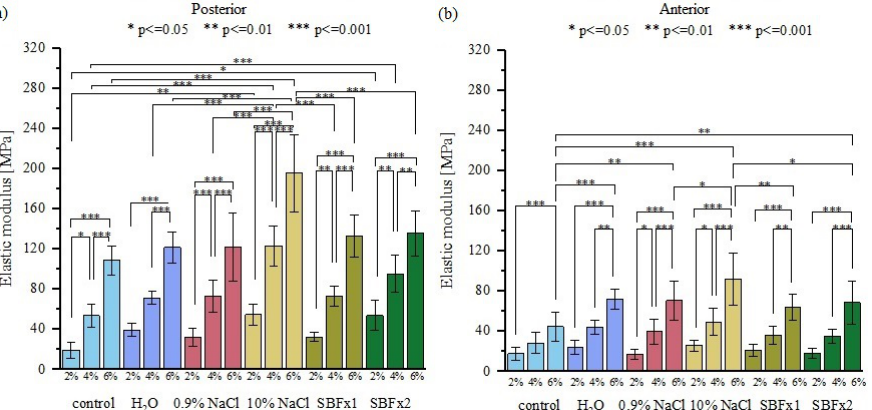
Figure 9. A comparison of the elastic modulus obtained from ( a ) posterior side and ( b ) anterior side of the tendon for three different values (2, 4, and 6%) of strain. Elastic modulus is given for control samples and for samples rehydrated for 15 min in distilled water, 0.9% NaCl, 10% NaCl, SBF, and SBFx2; p < 0.05; n = 10.